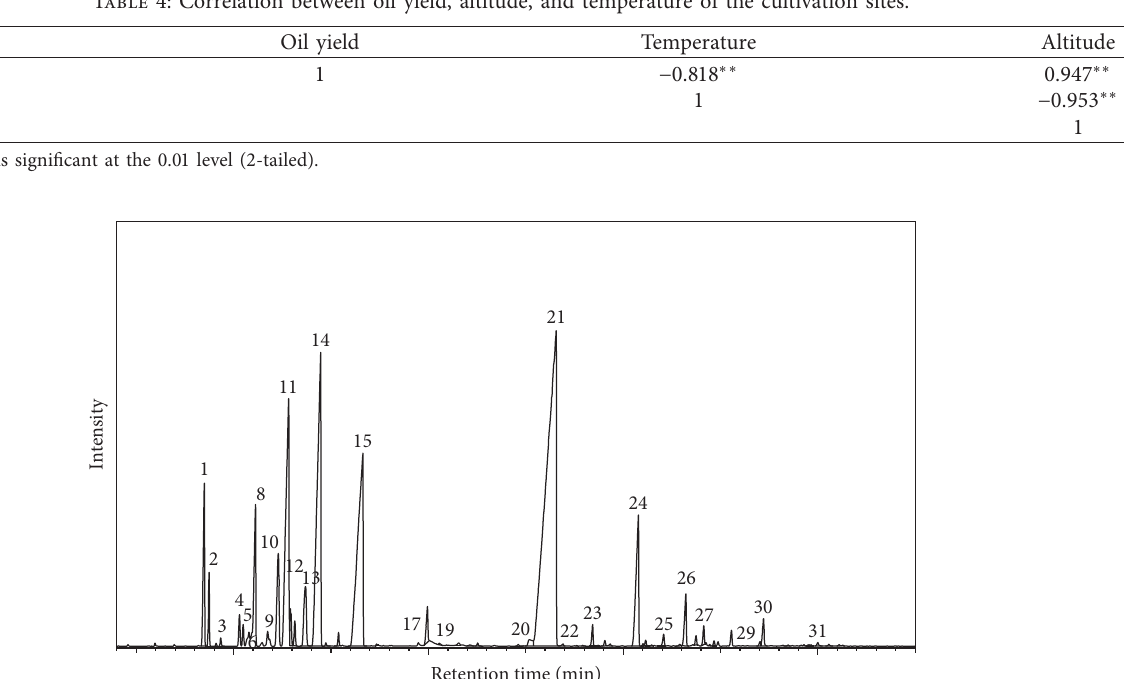
Figure 1: Gas chromatogram of the essential oil of O. vulgare grown at Auli (OV1).